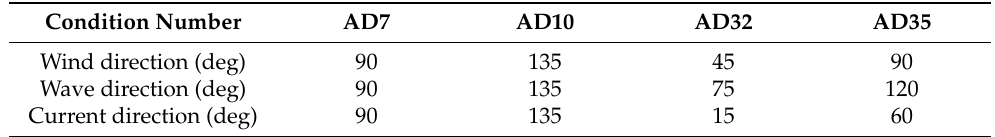
Table 12. Test set environment combination